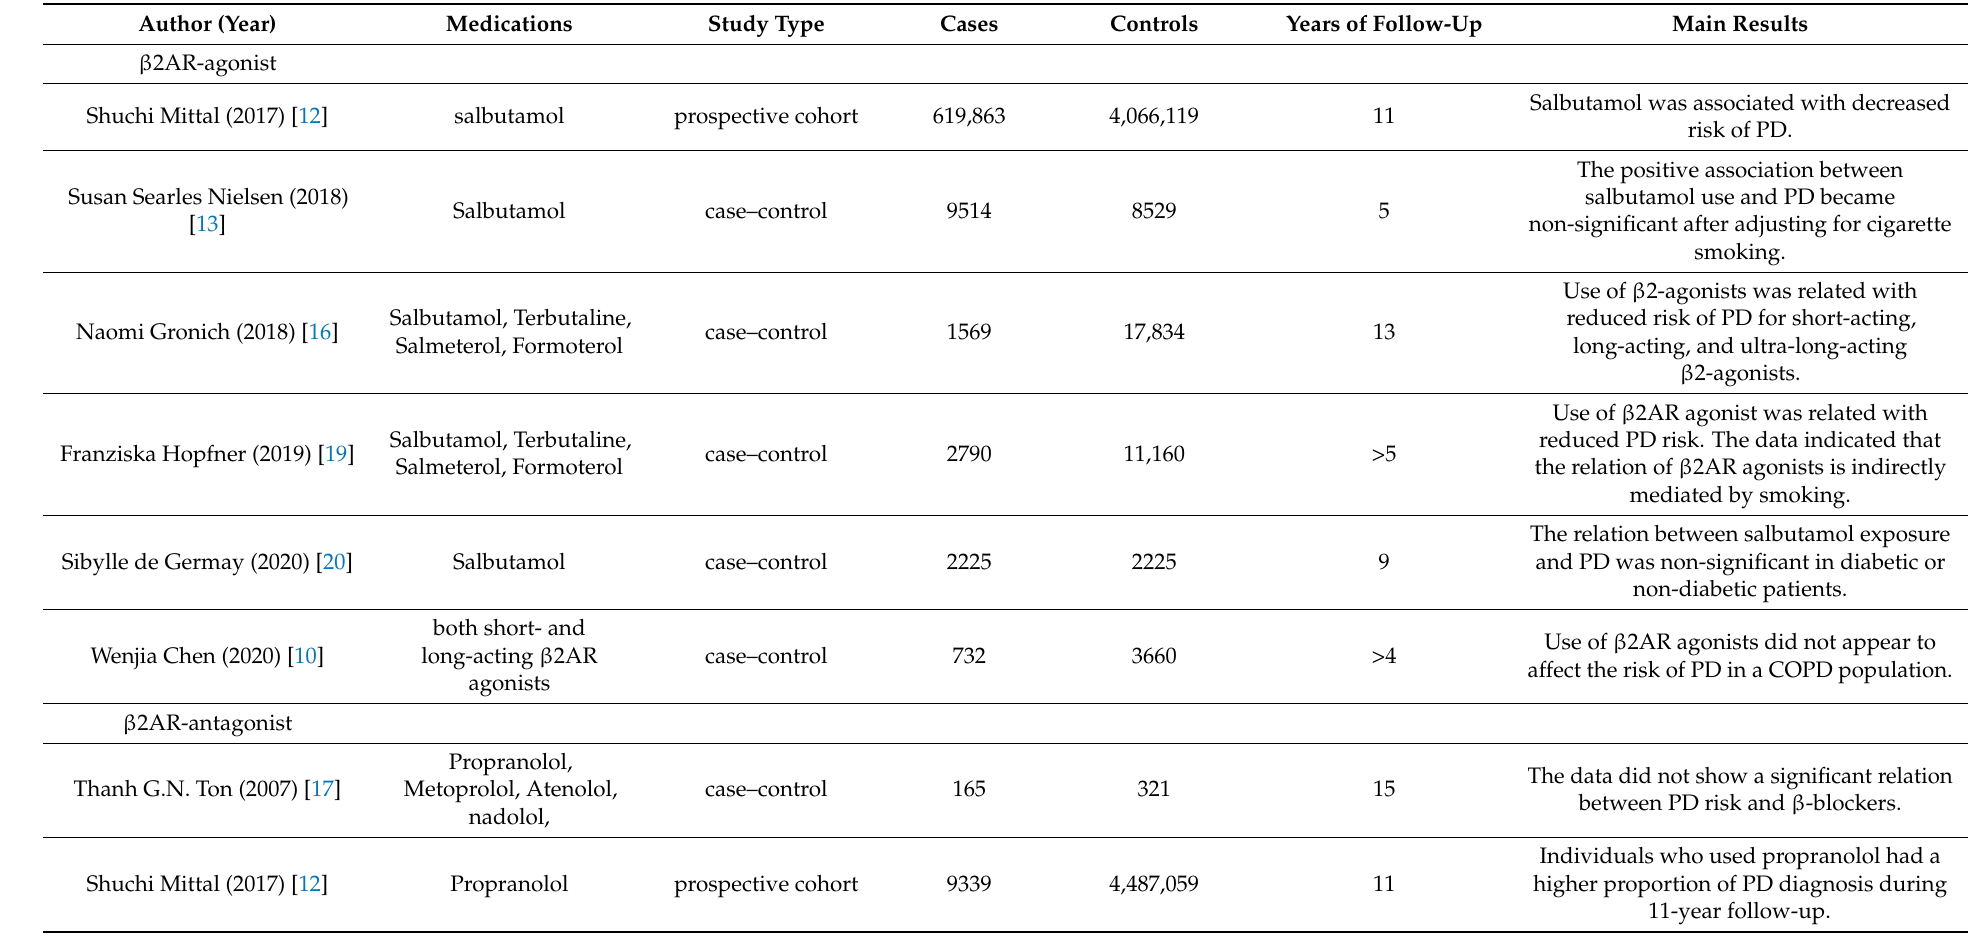
Table 1. Summary of study characteristics in this